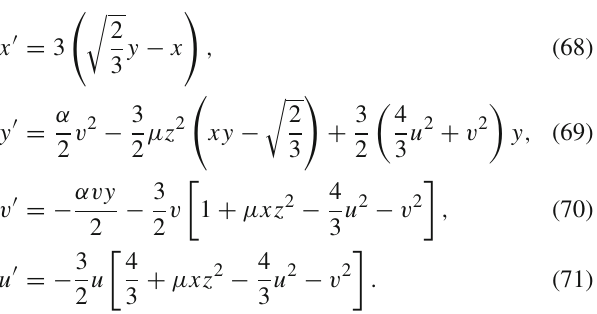
In Table 4 there are six critical points of which the first four namely P 0 – P 3 are equivalent to the critical points C 0 , C 2 – C 4 respectively in Table 1 from cosmological view point. The critical point P 4 describes the cosmic evolution due to interacting DE and CDM for α (cid:6)= ± 3. For α = ± 3; the matter is purely in the form of cosmological constant. So this critical point corresponds to scaling solution in cosmology. As long as the coupling parameter ‘ α ’ is restricted as α 2 < 3 then CDM dominates over DE otherwise there is accelerated expansion. For critical point P 5 the DE in the form of a scalar field interacting with CDM. But here cosmic evolution is dominated by DE and is in the de-Sitter era of